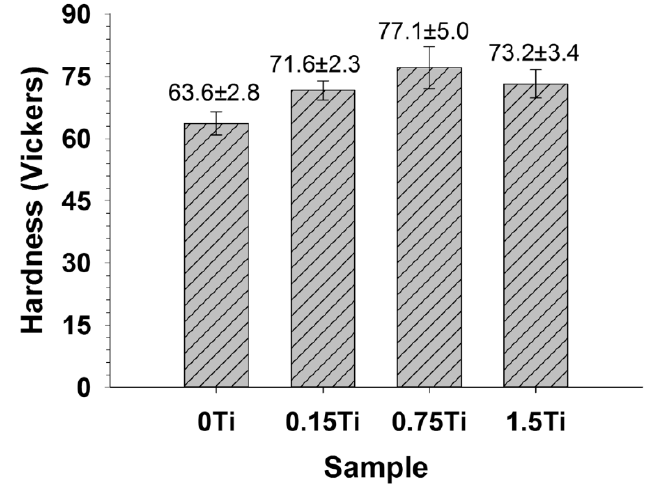
Figure 4. The average Vickers microhardness (mean ± STD value) measured on the samples.